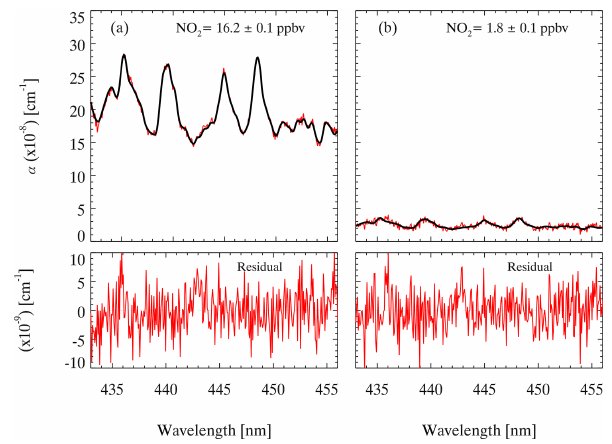
Figure 4. An example of the spectral fit for an extinction spectrum measured (6s average) during field measurements. The fitted results of NO 2 are shown, and the total fit result and the residual at high concentrations (a) and low concentrations (b) are shown.